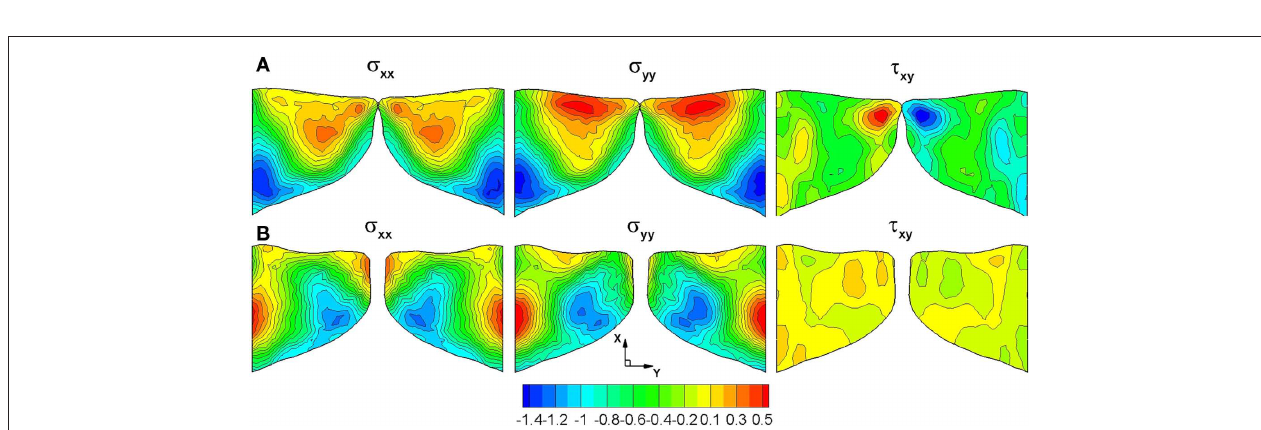
Figure 9 | (A) Time variation of glottal flow rate, (B) time variation of projected glottal area, (C) Computed VF deformation (top) which can be directly compared to high-speed video recordings (bottom).